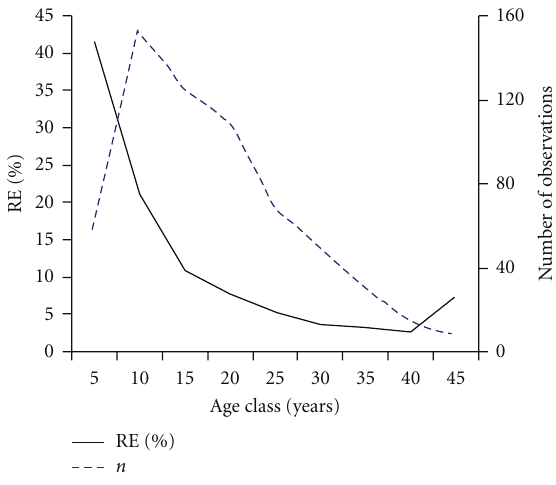
Figure 7: Site index predictions against total age using model M6 and the stem analysis data.